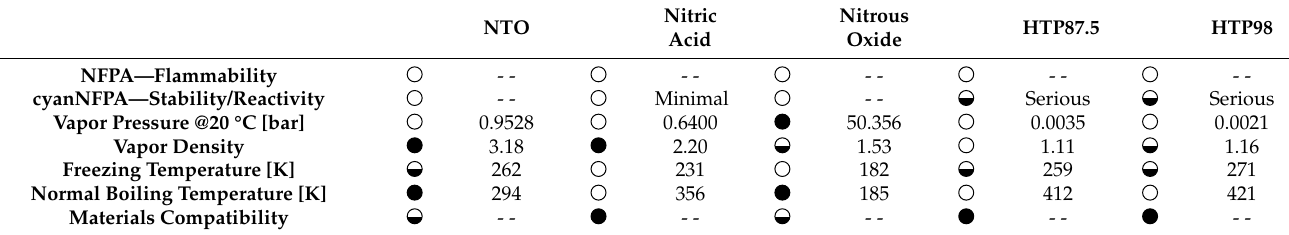
Table 10. Oxidizers handling and safety